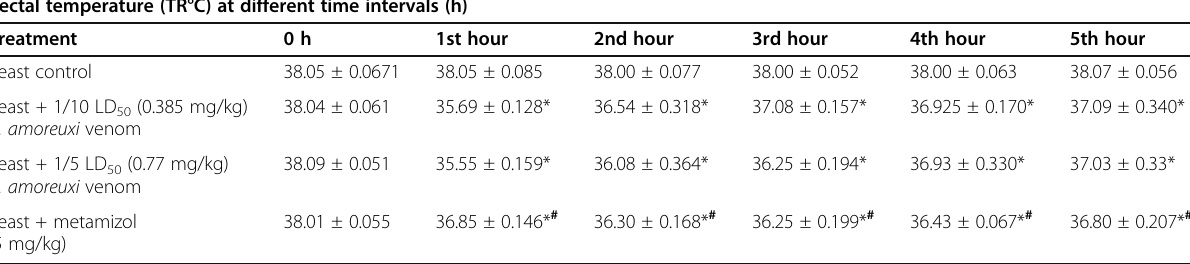
Table 1 Antipyretic effect of A. amoreuxi venom using Brewer ’ s yeast-induced pyrexia in rats Rectal temperature (TR°C) at different time intervals (h)